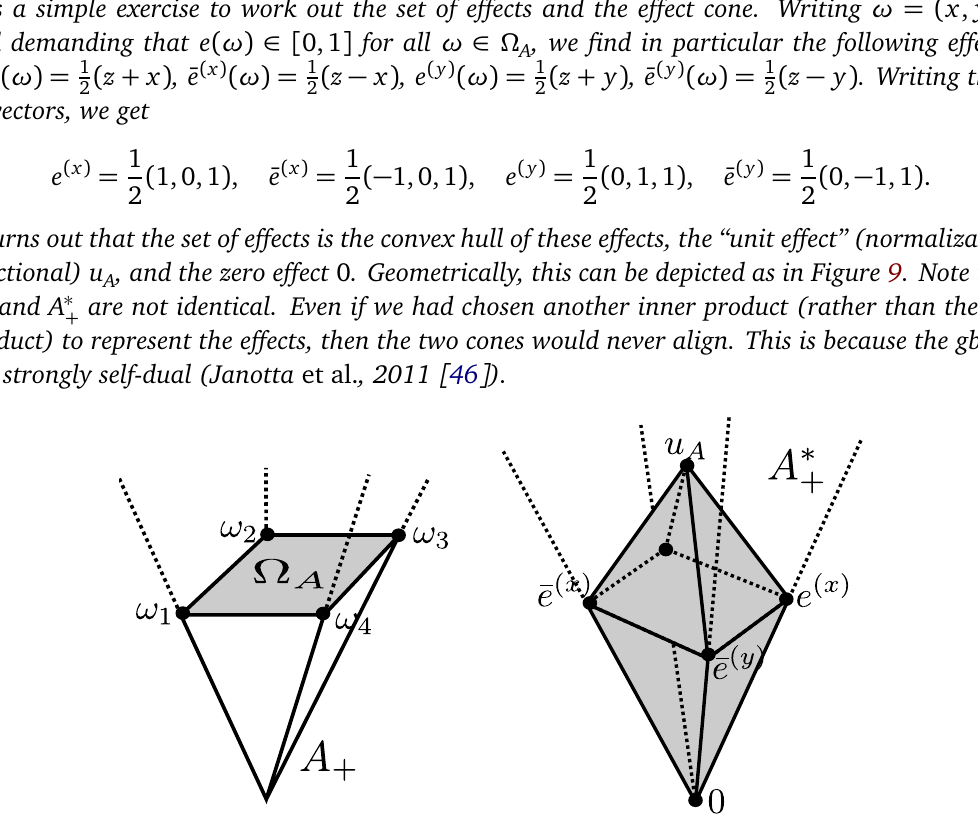
Figure 9: The “gbit” state space (generalized bit). Left: the state cone, with the normalized states in gray. Right: the effect cone, with the set of effects in